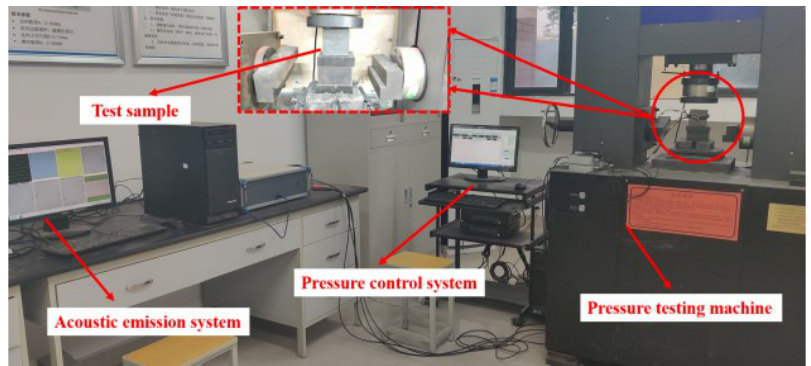
Figure 9. Test Figure 9. Test system.